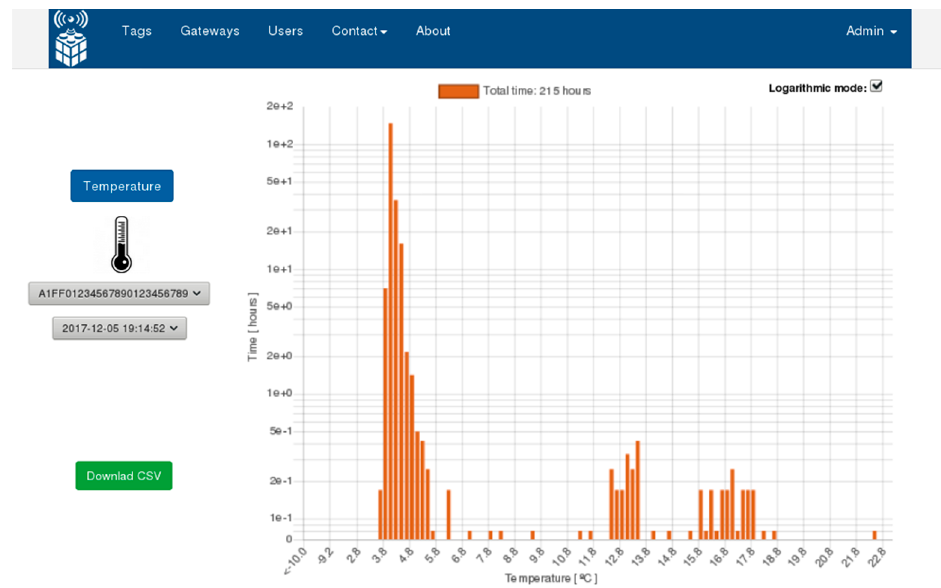
Figure 7. Graphical user interface, third-party application.